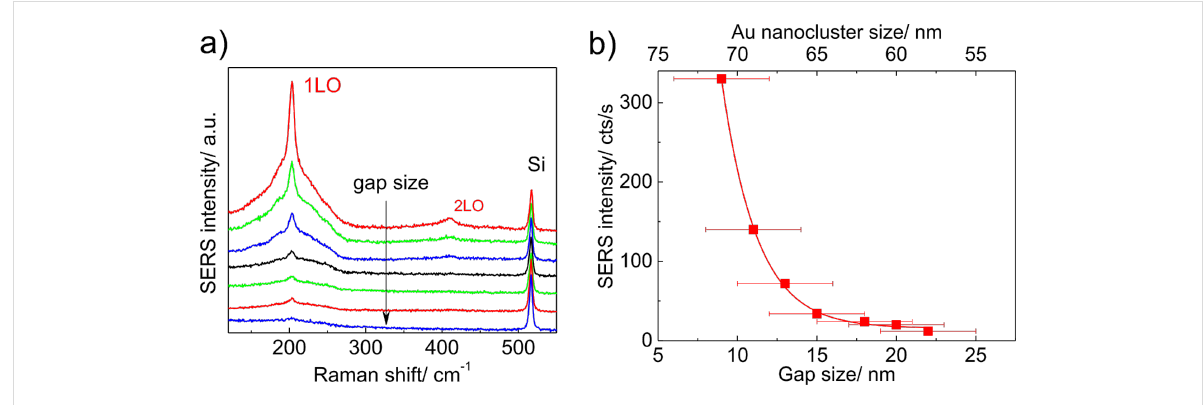
Figure 7: (a) SERS spectra of a submonolayer of CdSe NCs deposited on dimer arrays with increasing gap size measured at λ L = 632.8 nm with light polarized parallel to the long dimer axis. (b) The dependence of SERS intensity on the gap size and Au nanocluster size.